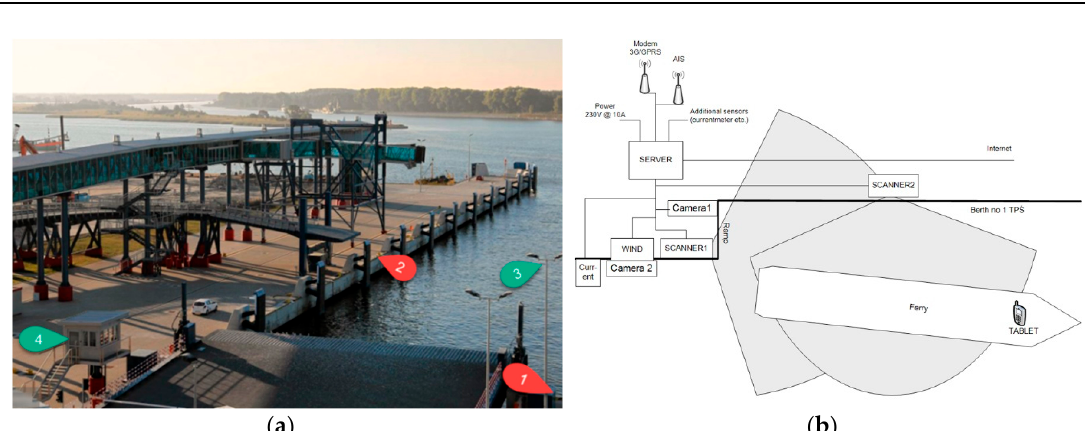
Figure 8. Ferry post no 1 in Ś winouj ś cie port and the location of the system devices: 1, 2—laser scanners, 3—anemometer and camera, 4—camera, AIS receiver, server ( a ), photo taken by C.Aszkiełowicz. System diagram ( b ).